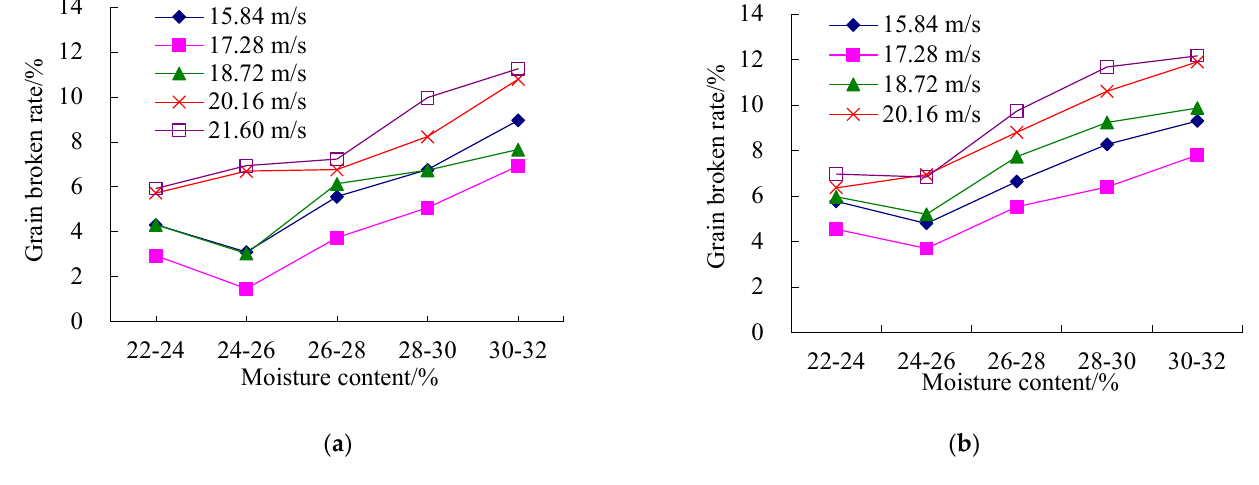
Figure 12. The relationship between the moisture content and grain broken rate under various drum peripheral velocity conditions. ( a ) TD1; ( b ) TD2.